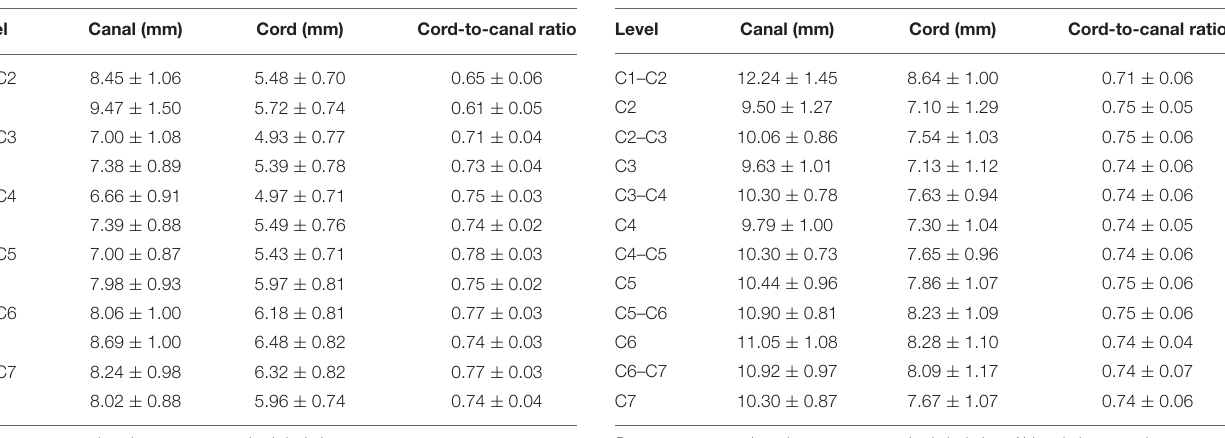
TABLE 3 | Widths of the spinal canal and cord measured on transverse images and ratio of the width of the spinal cord to the canal.